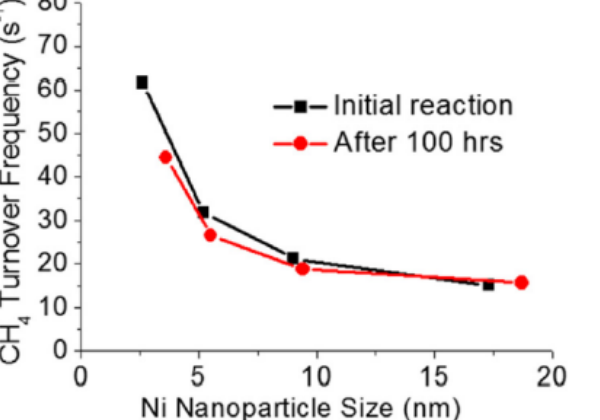
Figure 16. Effect of Ni nanoparticle size on CH 4 turnover frequency. Reprinted with permission from Ref. [186]. Copyright 2017 Elsevier.